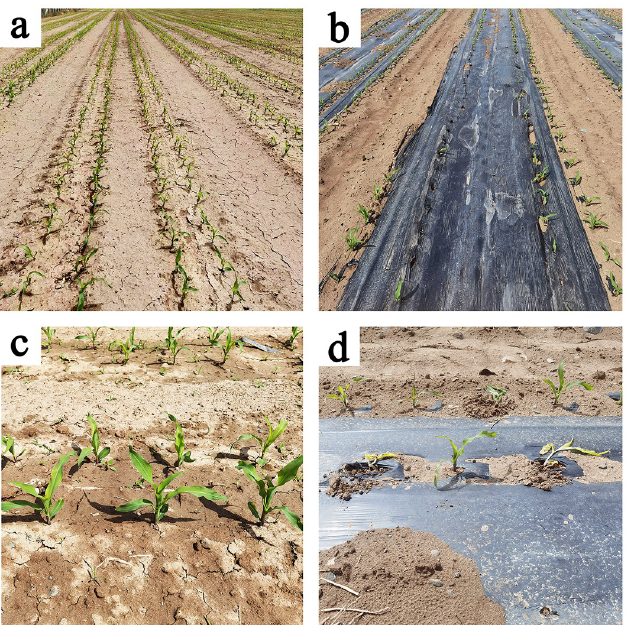
Fig 5. The silage corn in experimental plots under the CDLM (a and c) and PE (b and d) films at VE stage. non-degradation of PE films. The progressive fragmentation of CDLM during crop growth establishes a solid basis for the increase of the yield.